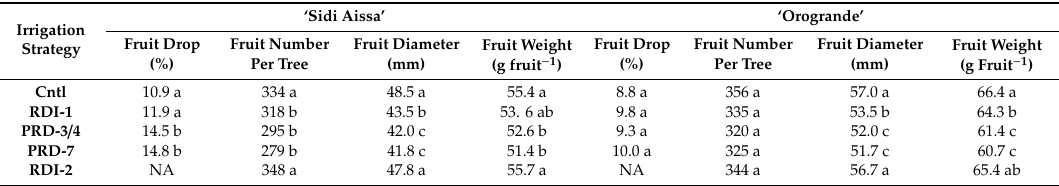
Table 2. E ff ect of irrigation strategies on fruit drop (as % of fruit fallen between the dates of 6 July and 10 September 2017), and on fruit count per tree and on individual fruit diameter and individual fruit weight for ‘Sidi Aissa’ and ‘Orogrande’ clementines at harvest date (2 October 2017) ‘Sidi Aissa’ ‘Orogrande’ Irrigation Fruit Drop Fruit Number Strategy (%) Per